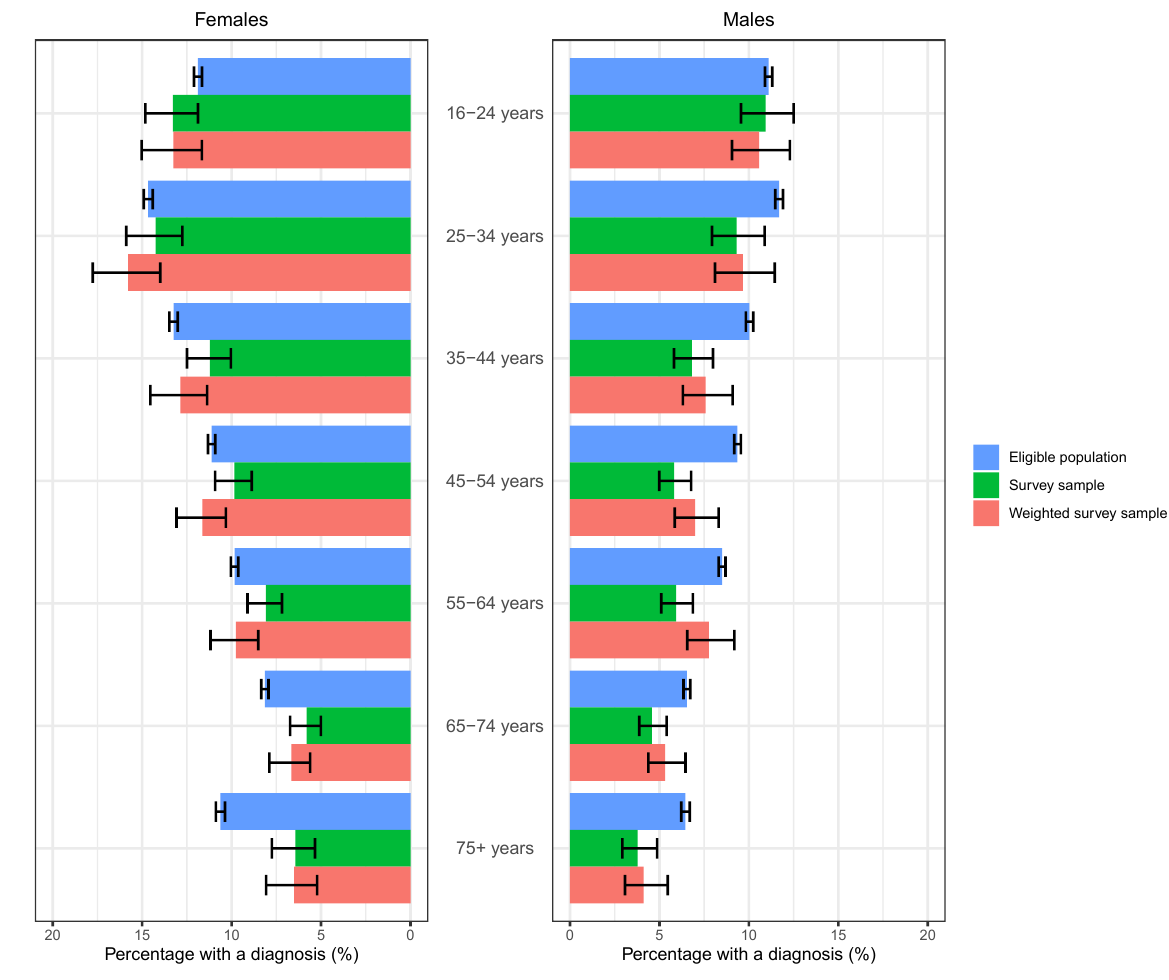
Figure 2: Prevalence of mental disorder diagnoses between all those eligible for the 2017 Central Denmark Region How are you? survey and the the survey participants (before and after weights were applied), by sex and age